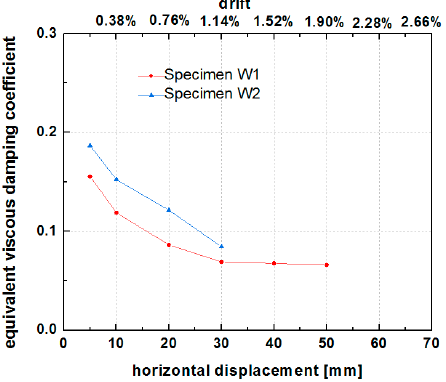
Figure 18. Equivalent viscous damping coefficient of specimens W1 and W2.